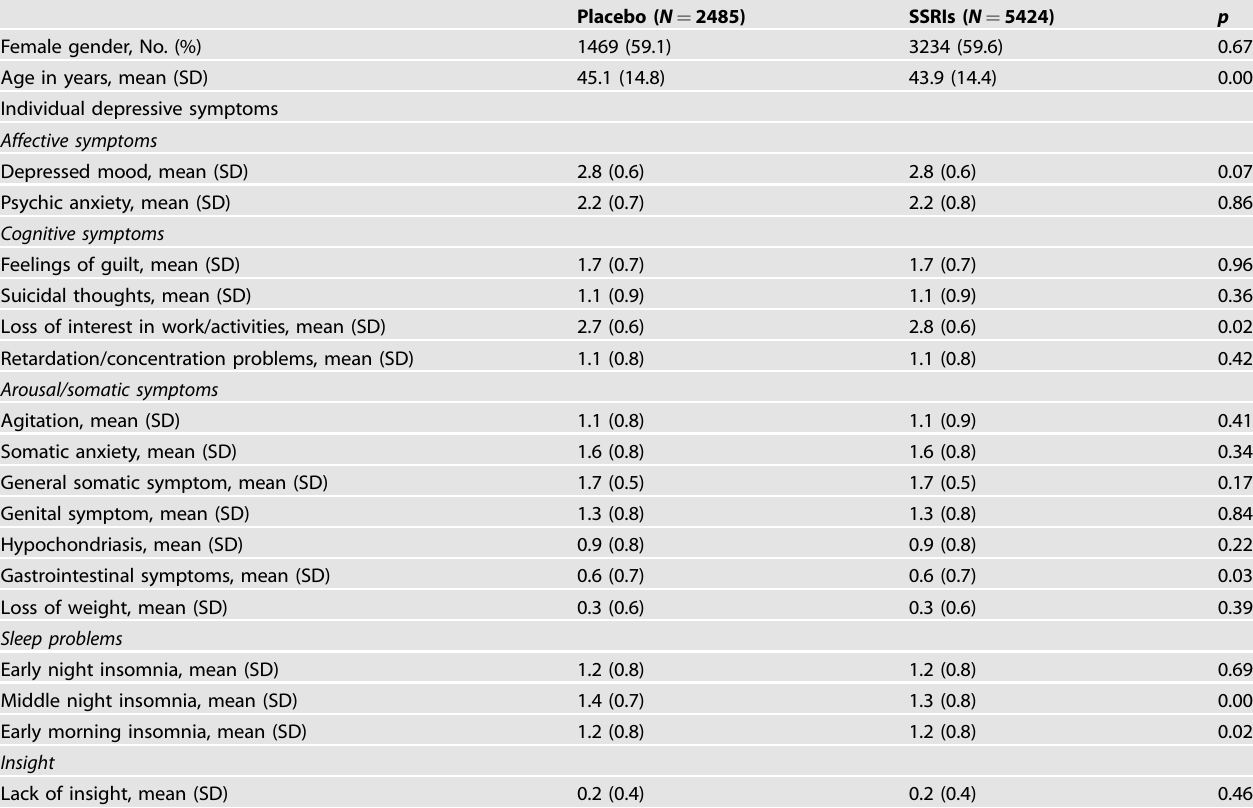
Table 1. Baseline